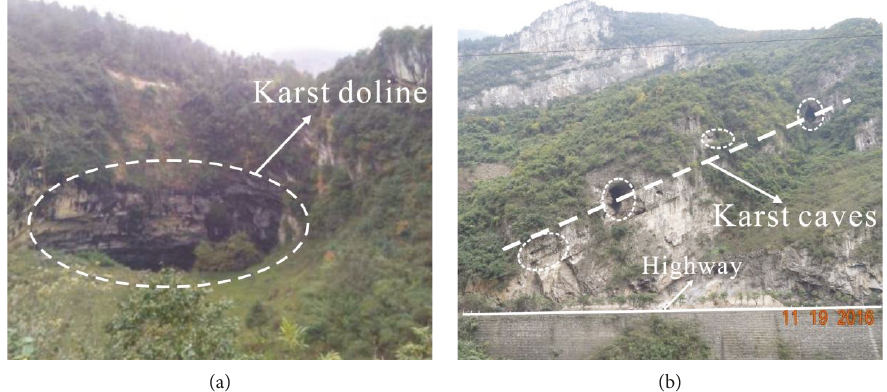
Figure 4: Karst phenomena in the study area ((a) karst doline; (b) karst